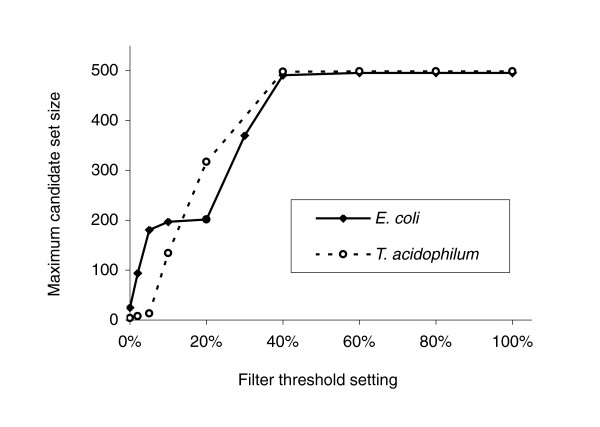
Effect of filter threshold setting on maximum number of candidate set members per query.